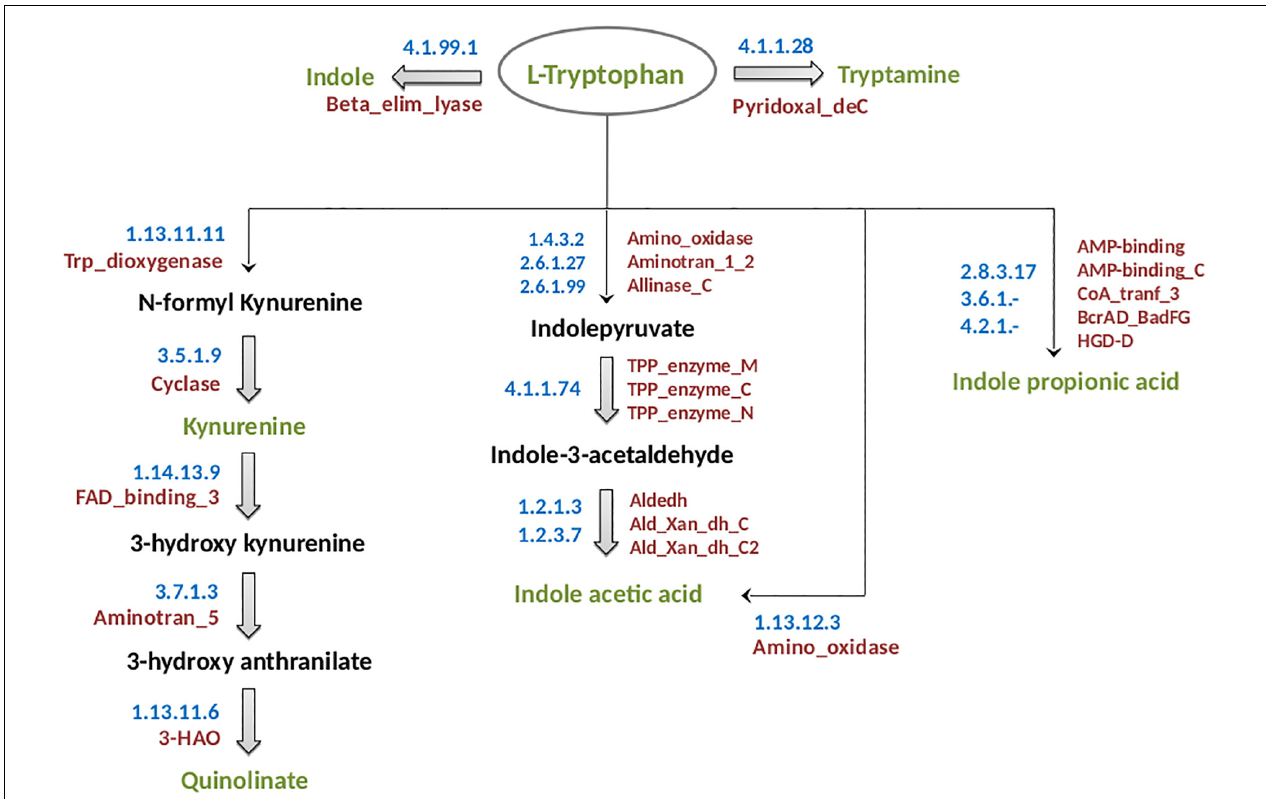
FIGURE 1 | Schematic representation of tryptophan metabolism pathways leading to production of neuro-active compounds. The pathways correspond to metabolism of tryptophan (indicated in green font inside an oval) for production of six neuro-active compounds namely, indole, tryptamine, kynurenine, quinolinate, indole acetic acid, and indole propionic acid. These six compounds have been indicated in green font. The intermediate compounds of the pathways have been represented in black font. For each pathway, the EC numbers and the functional domains of the participating enzymes have been indicated in blue and red colors,